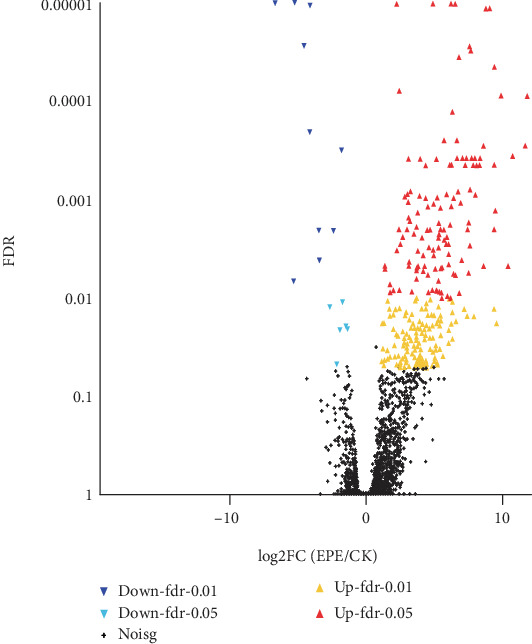
Volcano plots of DEGs. Note: differentially expressed genes (DEGs). The abscissa is the fold change of the gene's expression difference. The ordinate is the statistical test value of the difference in the amount of gene arrival, and the higher the p value, the more significant the difference in expression. Red dots indicate significantly upregulated genes, blue dots indicate significantly down-regulated genes, and black dots are nonsignificant differentially expressed genes.